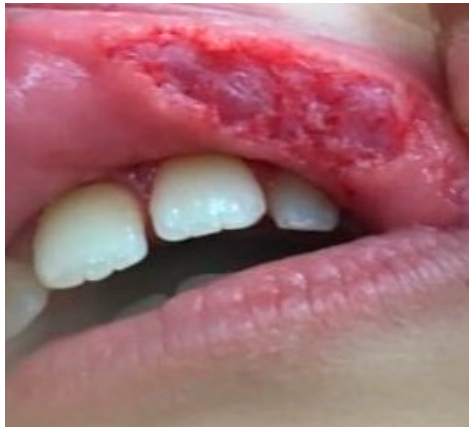
Figure 2. 14-year-old female patient, with a large wound on her upper lip, non-bleeding area of 1 × 2 cm on the non-keratinized mucosa, surrounded by erythema that did not involve the vermilion border.